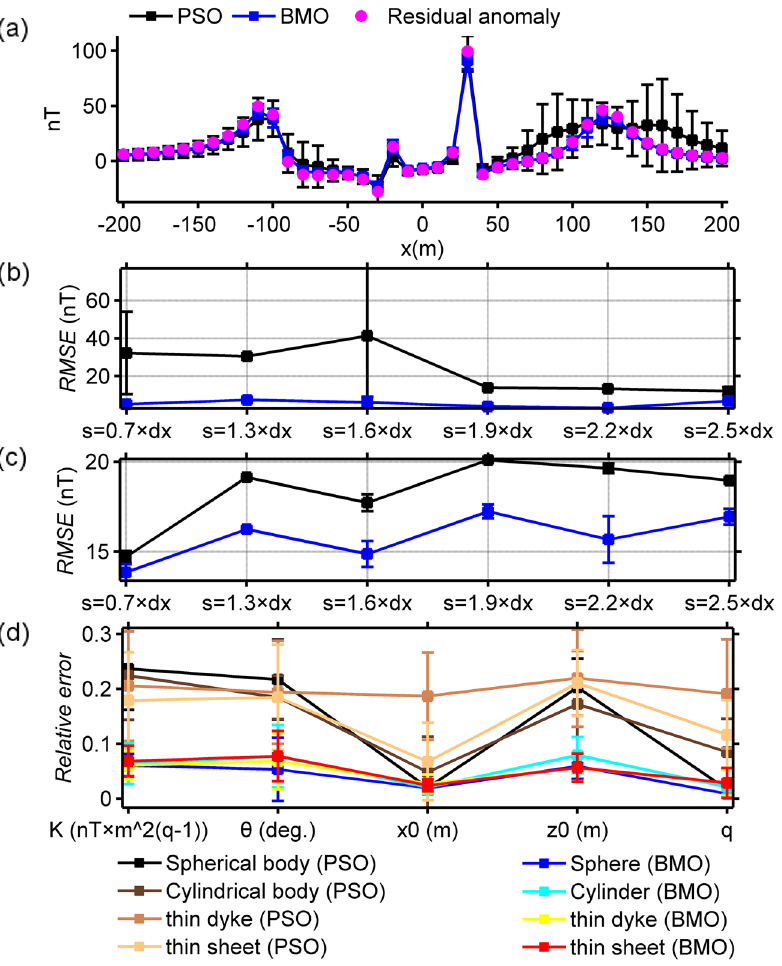
Figure 10. Inversion results of case 2 with the implementation of the SMA technique. ( a ) fittings between the pure residual magnetic anomaly and the responses obtained via BMO and sPSO, ( b ) variation behavior of the calculated RMSE values between the uncontaminated magnetic anomaly of case 1 and the residual responses obtained via BMO and sPSO for different s values, ( c ) variation behaviors of the computed RMSE values between the calculated SMA magnetic anomalies of case 2 and the estimated SMA magnetic responses of BMO and sPSO for different s values, ( d ) relative errors of the calculated average estimation of the obtained model parameters using BMO and sPSO for four causative sources from the SMA magnetic anomalies for several s values. Error bars are given in ( a )–( d